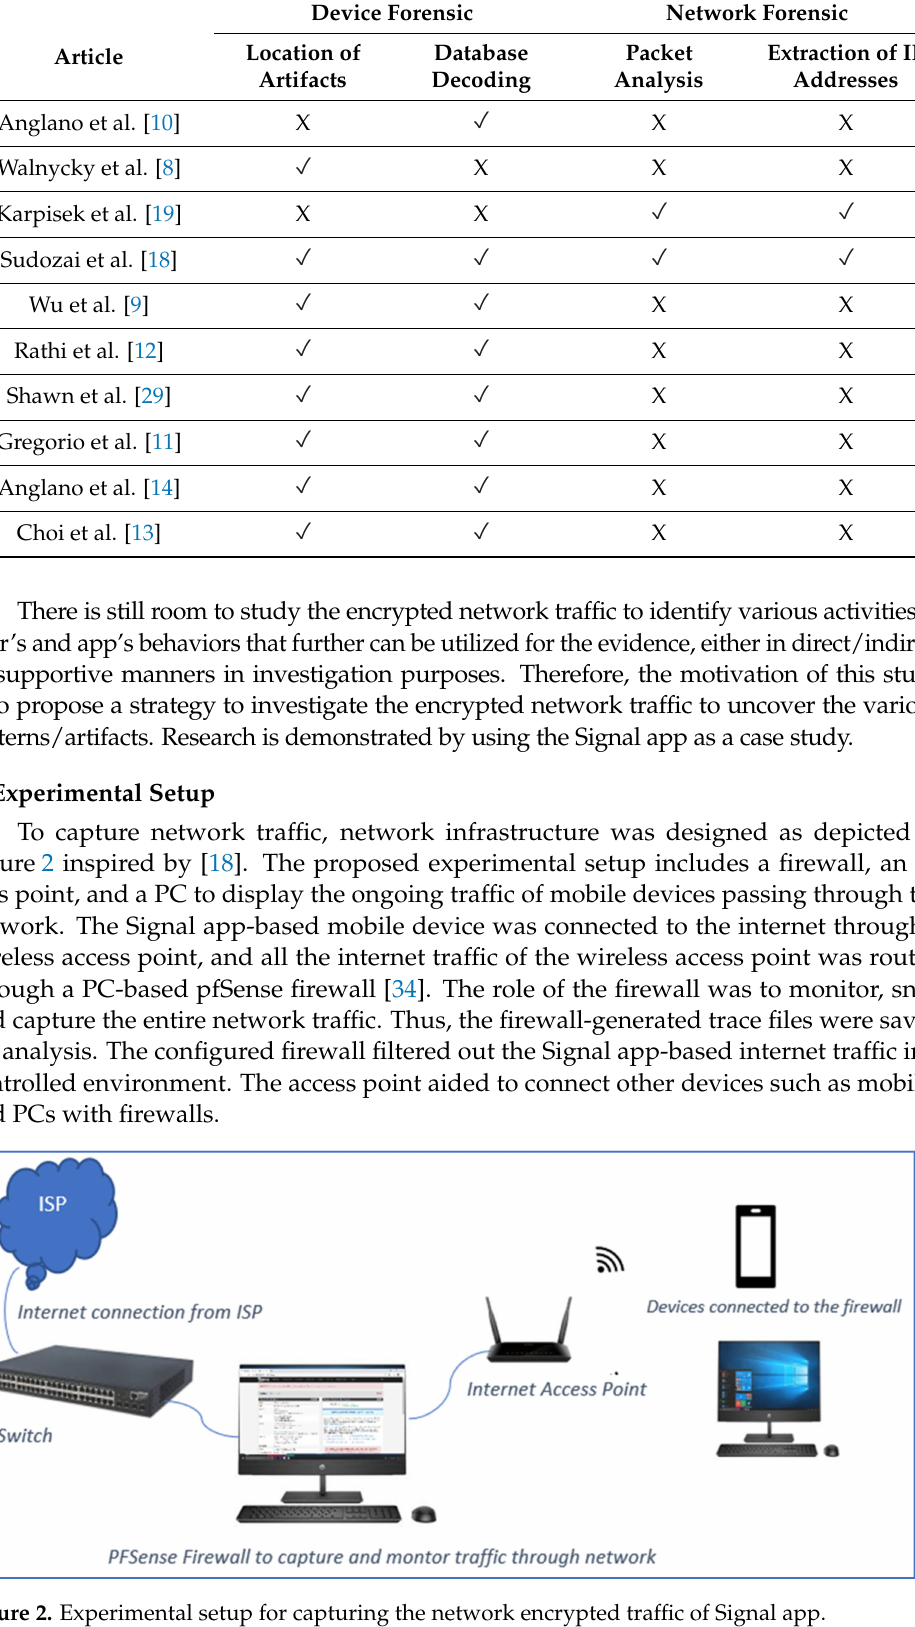
Table 1. A comparison of device and network forensic analysis for android apps.